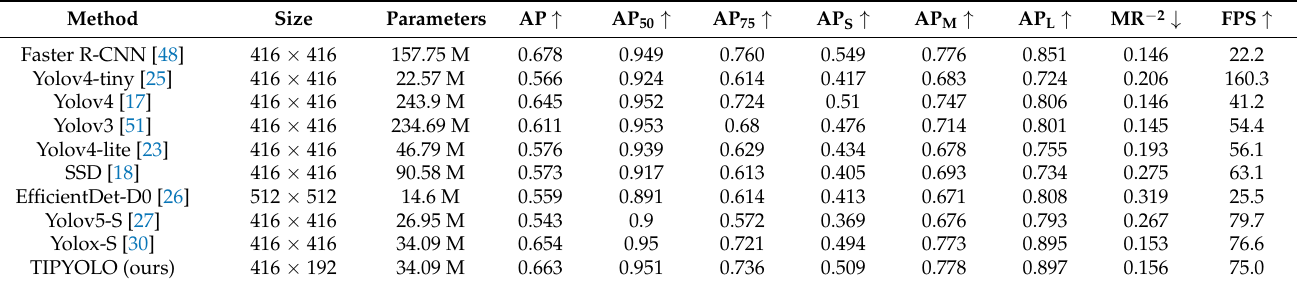
Table 3. The comparison results of the methods on the YDTIP dataset. “ ↑ ” indicates that the larger the value, the better the performance; “ ↓ ” indicates that the smaller the value, the better the